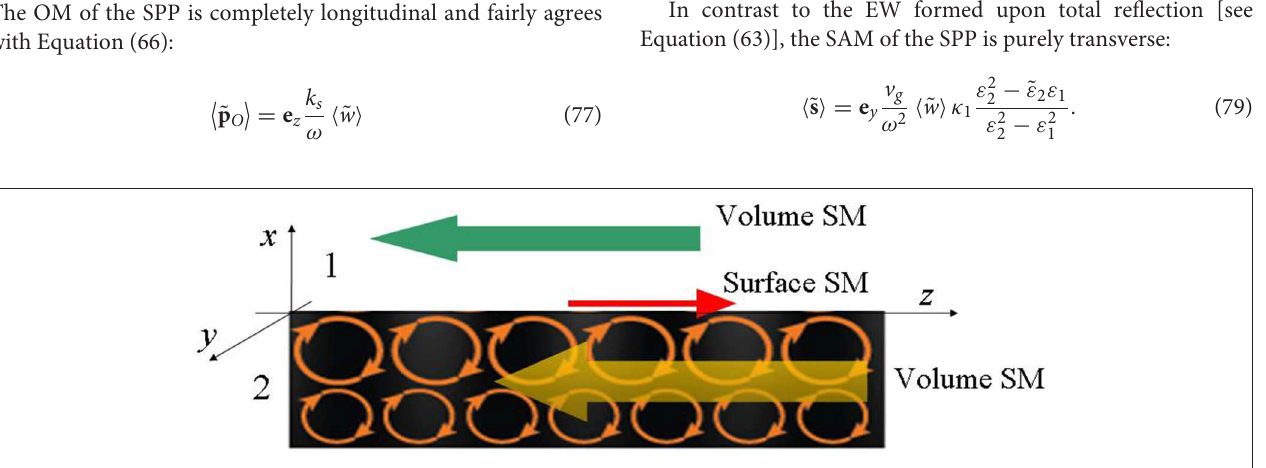
FIGURE 9 | Illustration of the elliptic trajectories of electrons and the SM constituents [82]. The ellipses’ sizes and the electron velocities decay with the off-surface distance in the half-space x < 0.